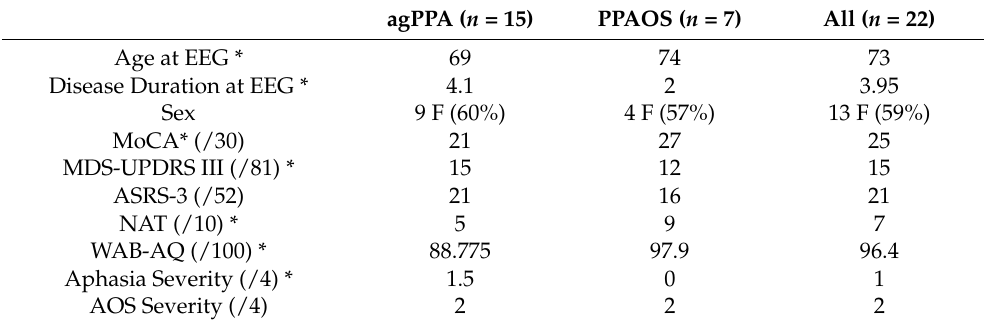
Table 2. Median clinical and demographic information for this cohort and subgroups. agPPA ( n =